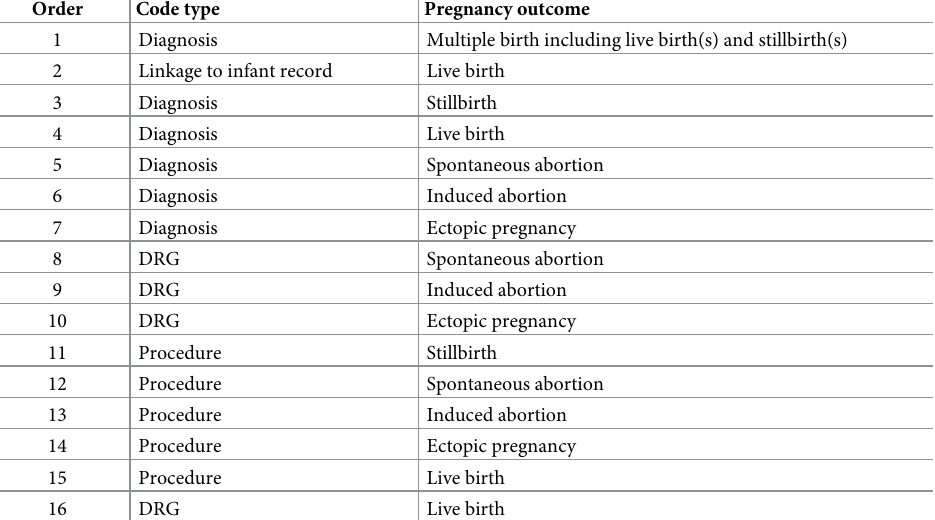
Table 1. Pregnancy algorithm hierarchy of initial pregnancy outcome, based on outcome type and code type pres- ent (Diagnosis, Procedure, or Diagnosis-Related Group